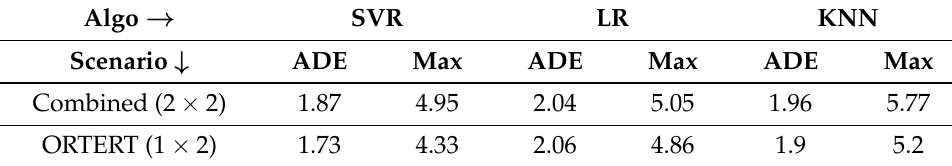
Table 11. ADE and maximum localization error at any TP for two practical